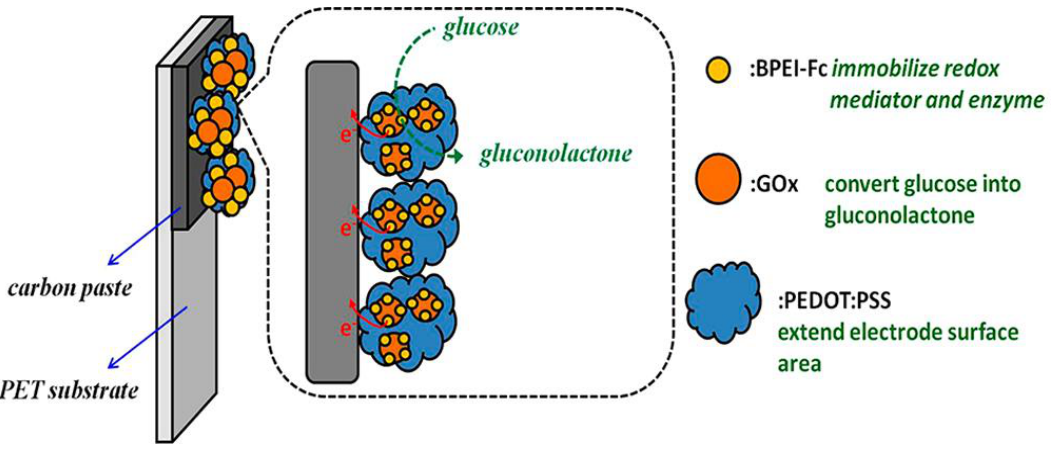
Figure 7. Redox polymer nanobeads composed of Fc-modified PEI for